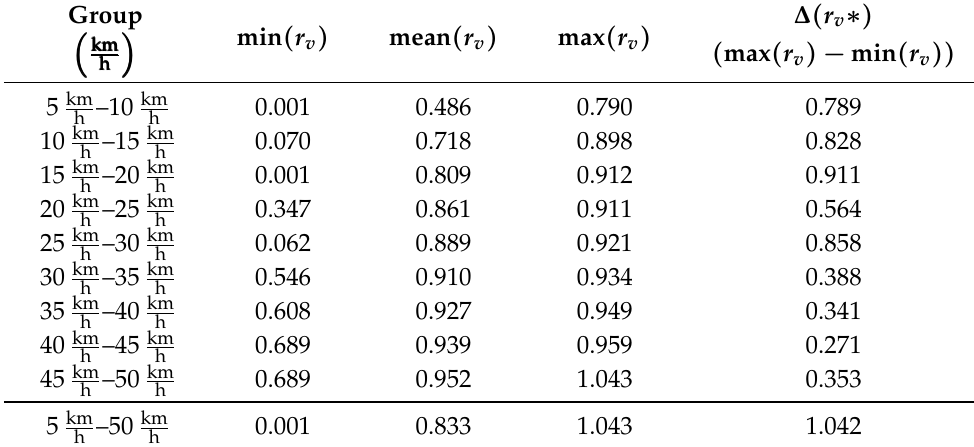
Table 10. Relation r v according to Equation (26). # of measurements: 3,428,099.